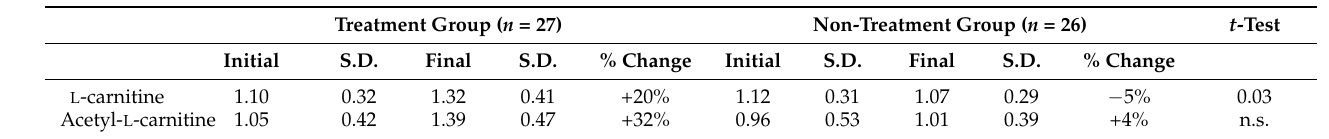
Table 20. Carnitine levels in